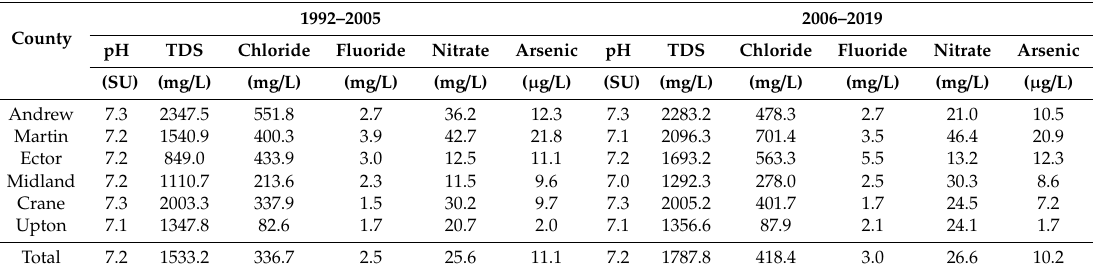
Figure 11. Spatial distribution of total groundwater quality from optimum to poor conditions in the study area for ( a ) 1992–2005 and ( b ) 2006–2019. Table 5. The averages of six groundwater parameters in the study area for (a) 1992–2005 and (b)